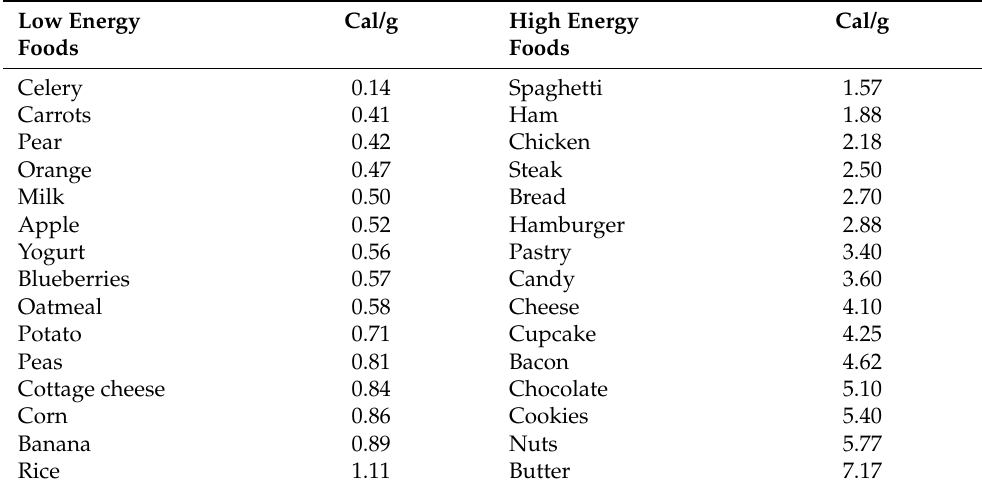
Table 1. Standard energy content of the presented food items (in calories per